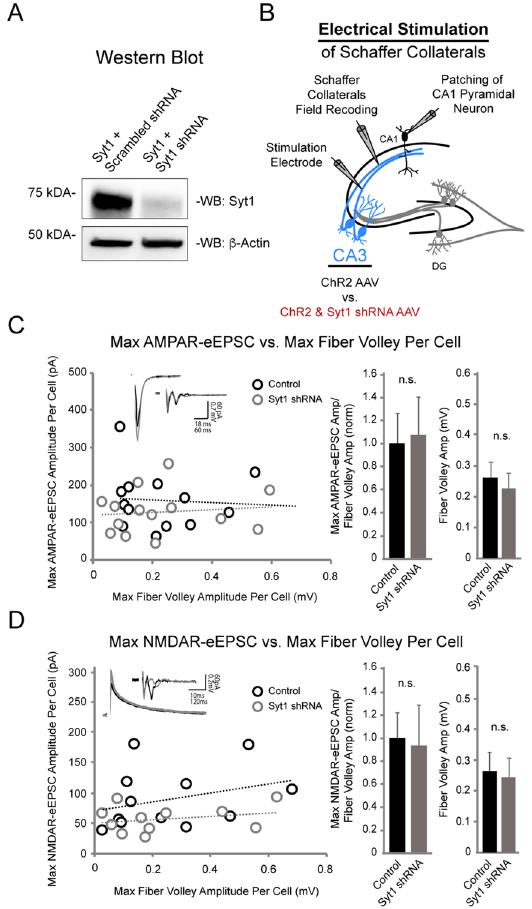
Figure 3. Deficits in CA3-CA1 excitatory synaptic transmission following Syt1 knockdown in CA3 pyramidal neurons are not observed with electrical stimulation. ( A ) Western blot showing knockdown of Syt1 with Syt1 shRNA in HEK293 cells. Top: probed for Syt1, bottom: probed for ß-Actin. The same blot was used to probe for both proteins. Images have been cropped for clarity. Full-length blots are presented in Supplementary Fig. 1. ( B ) Schematic illustration of recording setup using electrical stimulation. AAV expressing either ChR2 only (control) or ChR2 with Syt1 shRNA were injected into CA3 pyramidal neurons, and Schaffer collaterals were electrically stimulated with an electrode. Schaffer collateral field recordings and whole-cell patch recordings of CA1 pyramidal neurons were simultaneously acquired. In ( C , D ), Wilcoxon rank sum test was used. * p < 0.05, n.s., not significant. ( C ) (Left) Max AMPAR-eEPSC/FV ratios per cell in control vs. Syt1 shRNA conditions following electrical stimulation. Each point represents the Max AMPAR-eEPSC/FV amplitude ratio of one cell; measurements from each condition were fitted with a linear regression line. Insets show representative traces from control (black) and Syt1 shRNA (gray) conditions with stimulation artifacts removed. (Center) Averaged and normalized Max AMPAR-eEPSC/FV amplitude ratio in control vs. Syt1 shRNA conditions following electrical stimulation (control n = 14, Syt1 shRNA n = 14, p = 0.31). (Right) Averaged fiber volley amplitudes in control vs. Syt1 shRNA conditions (control n = 14, Syt1 shRNA n = 14, p = 0.51). ( D ) (Left) Max NMDAR-eEPSC/FV ratios per cell in control vs. Syt1 shRNA conditions following electrical stimulation. Each point represents the Max NMDAR-eEPSC/FV amplitude ratio of one cell; measurements from each condition were fitted with a linear regression line. Insets show representative traces from control (black) and Syt1 shRNA (gray) conditions with stimulation artifacts removed. (Center) Averaged and normalized Max NMDAR-eEPSC/ FV amplitude ratio in control vs. Syt1 shRNA conditions following electrical stimulation (control n = 12, Syt1 shRNA n = 11, p = 0.12). (Right) Averaged fiber volley amplitudes in control vs. Syt1 shRNA conditions (control n = 12, Syt1 shRNA n = 11, p =